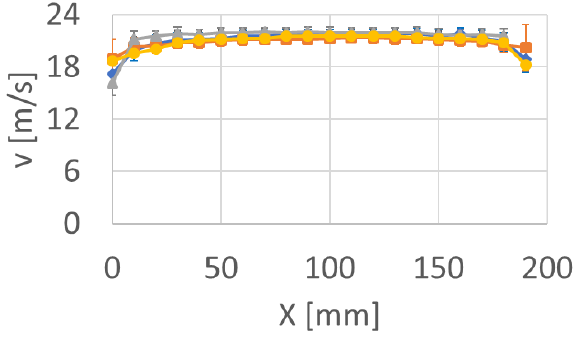
Fig. 9. Velocity profile, mean velocity of 21 m/s .